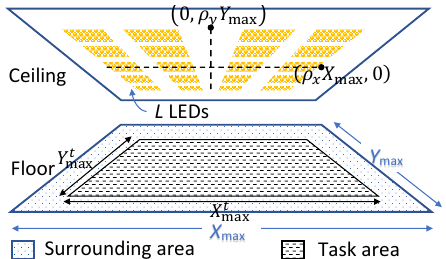
Figure 4. Receiver area lit by L LEDs uniformly grouped in P A , x × P A , y arrays on the ceiling within an area of ρ x X max × ρ y Y max .